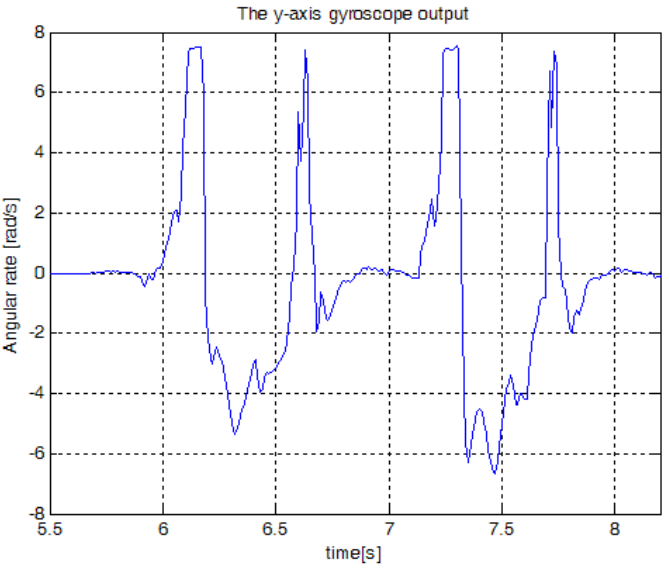
Figure 2. The y-axis gyroscope output in